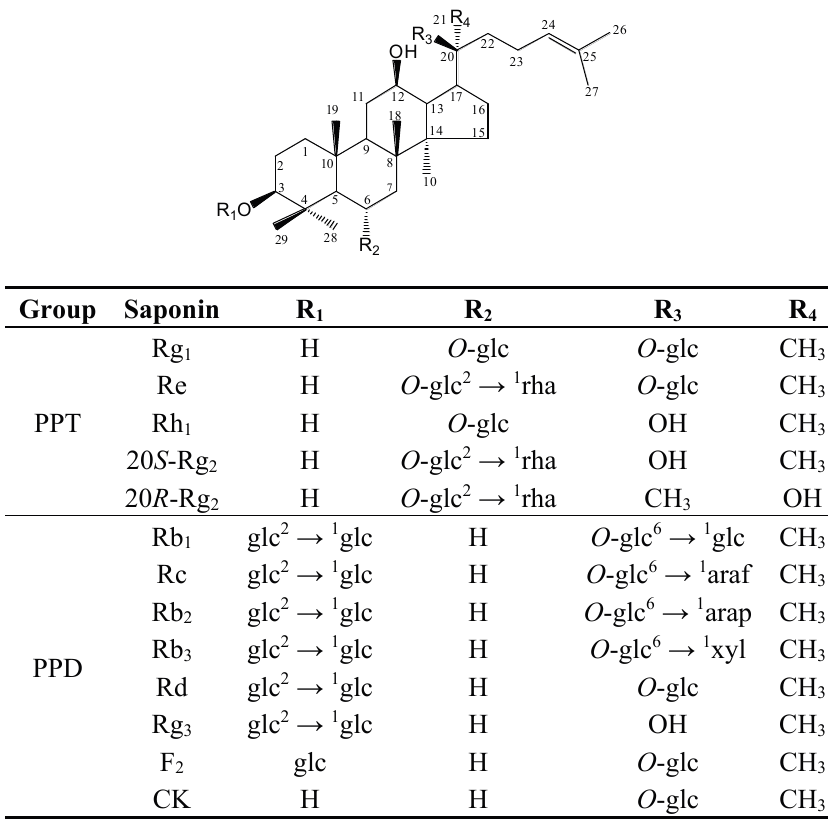
Figure 1. Chemical structures of ginseng saponins in American ginseng. Rg3, F2, and CK are gut microbiome metabolites of PPD group